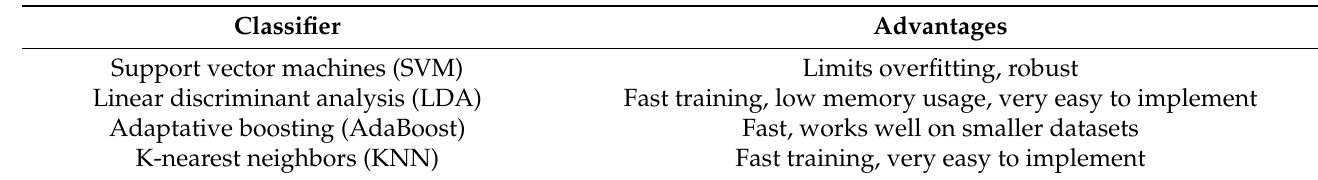
Table 2. Studied machine learning classifiers and their advantages.